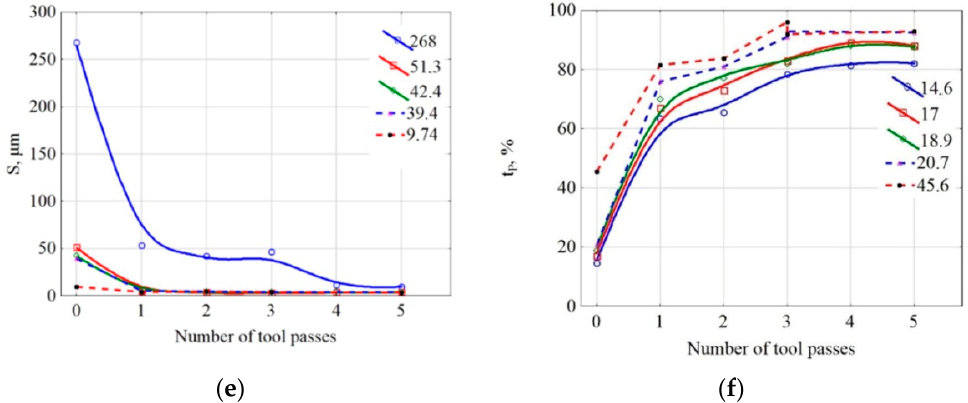
Figure 8. Functions of changes in roughness parameters Ra ( a ), Rz ( b ), Rtm ( c ), Sm ( d ), S ( e ), tp ( f ) on the number of passes for different initial roughness (in the upper right corner of each graph ( a – f ) the values of the roughness parameters of the samples measured after cutting and before ultrasonic surface deformation are indicated).